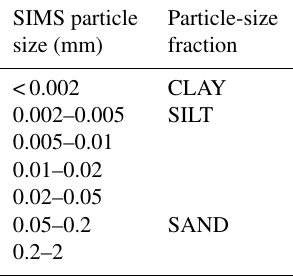
Table 2. Conversion of SIMS particle size distribution data into clay, silt and sand particle-size fractions according to the USDA size groups of mineral particles.